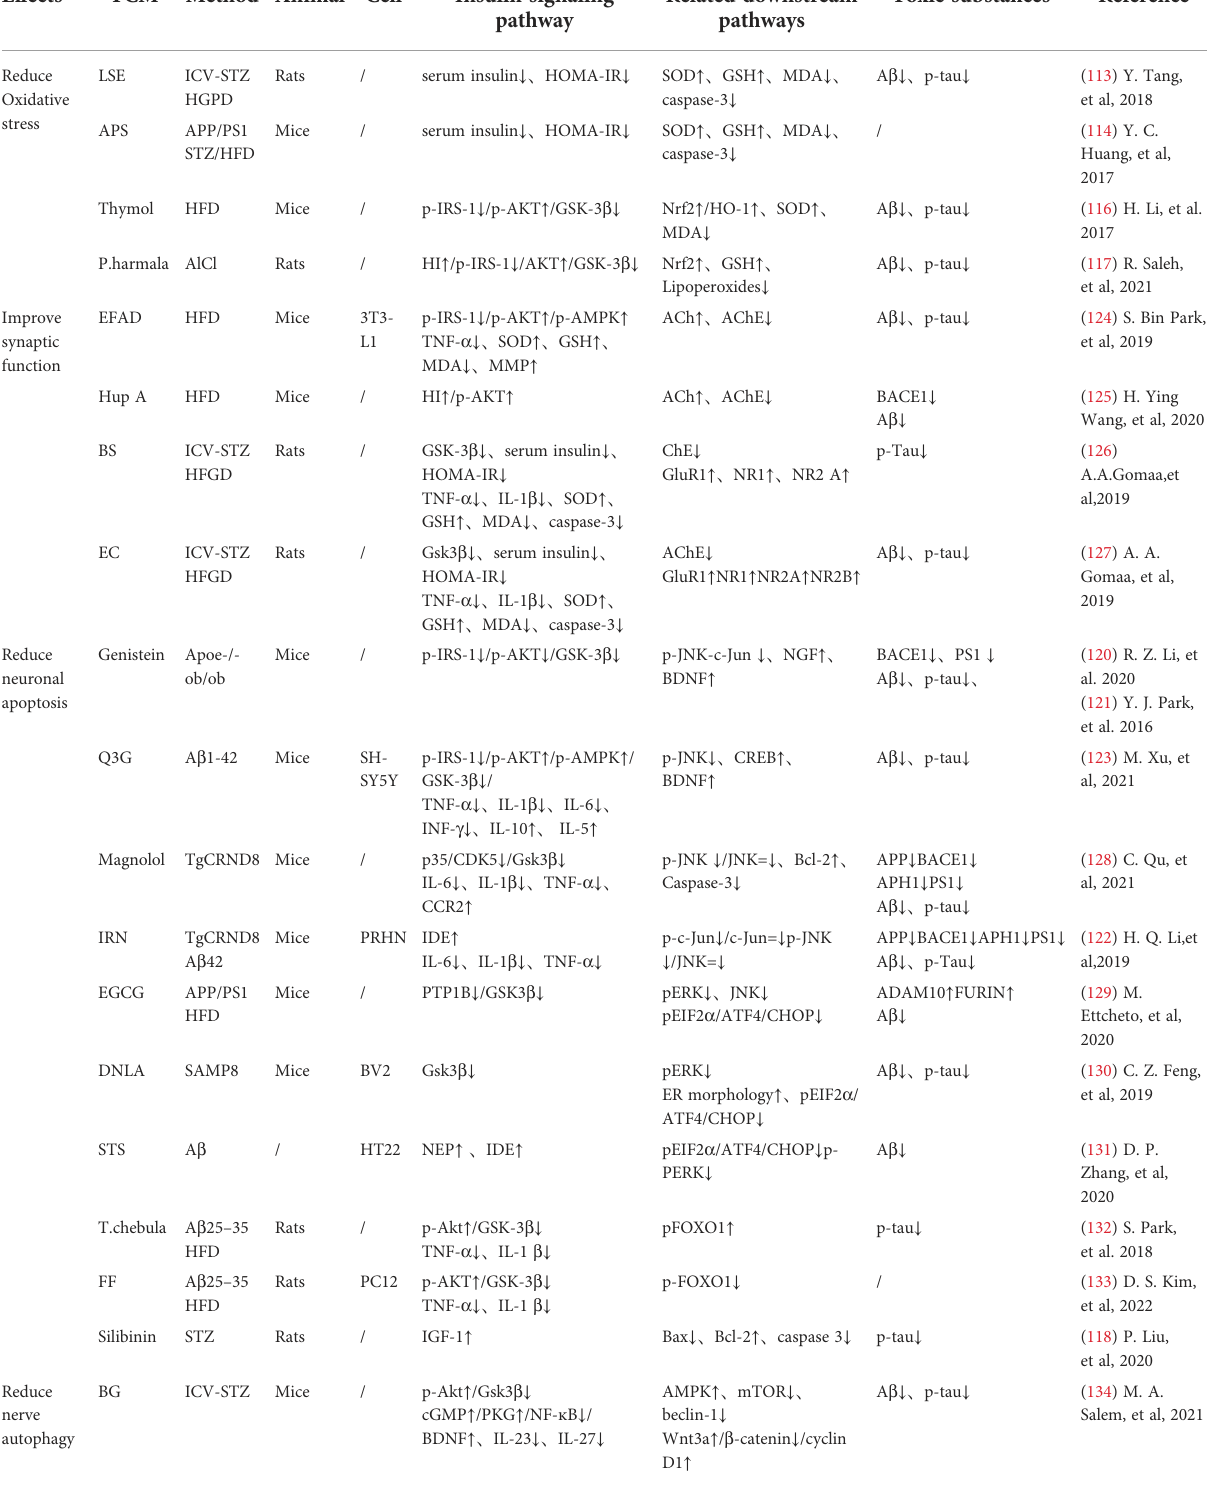
TABLE 2 TCM promotes neuronal survival through insulin signaling pathway and related downstream